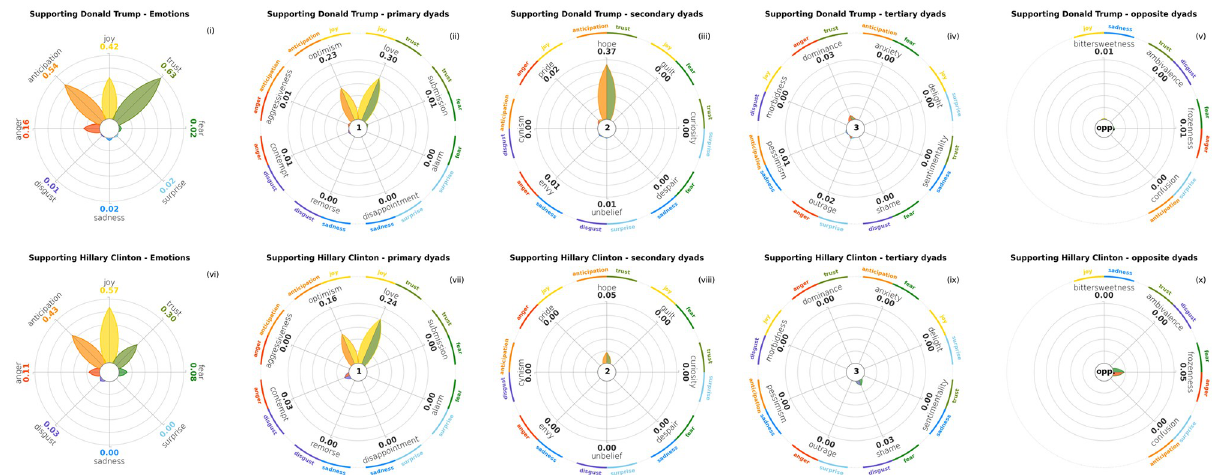
Fig 14. Tweets in favour of Donald Trump and Hillary Clinton from the 2016 StanceDetection task in SemEval. From left to right: basic emotions, primary dyads, secondary dyads, tertiary dyads and opposite dyads for both candidates (Donald Trump on the first row, Hillary Clinton on the second one). Despite the high amounts of Anticipation , Joy and Trust for both the candidates, which result in similar primary dyads, there is a significant spike on the secondary dyad Hope among Trump’s supporters that is not present in Clinton’s supporters.